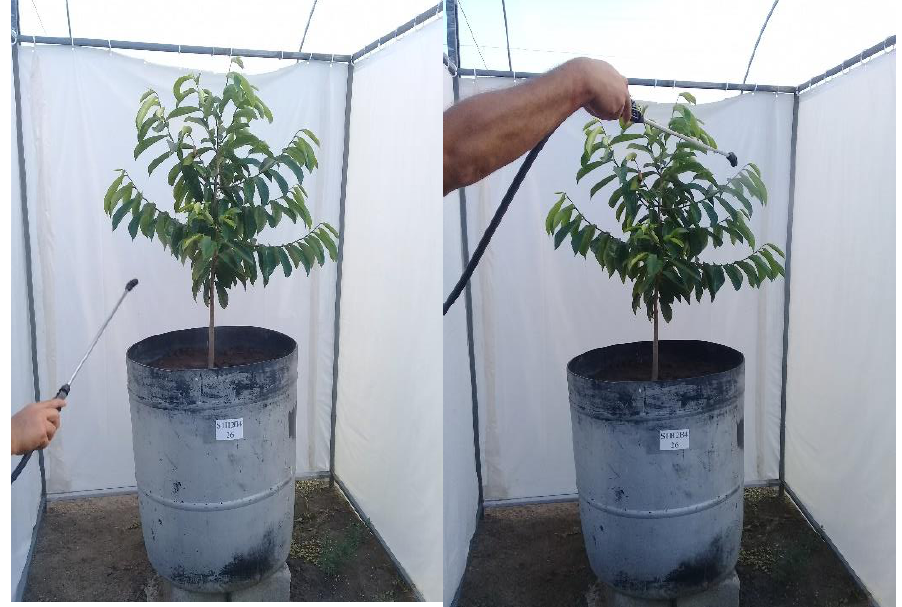
Figure 7. Application of hydrogen peroxide on the abaxial and adaxial sides of soursop leaves. Formative pruning was carried out as the plant reached 60 cm height when the apical meristem bud was cut. Of the shoots that emerged, three well-distributed and